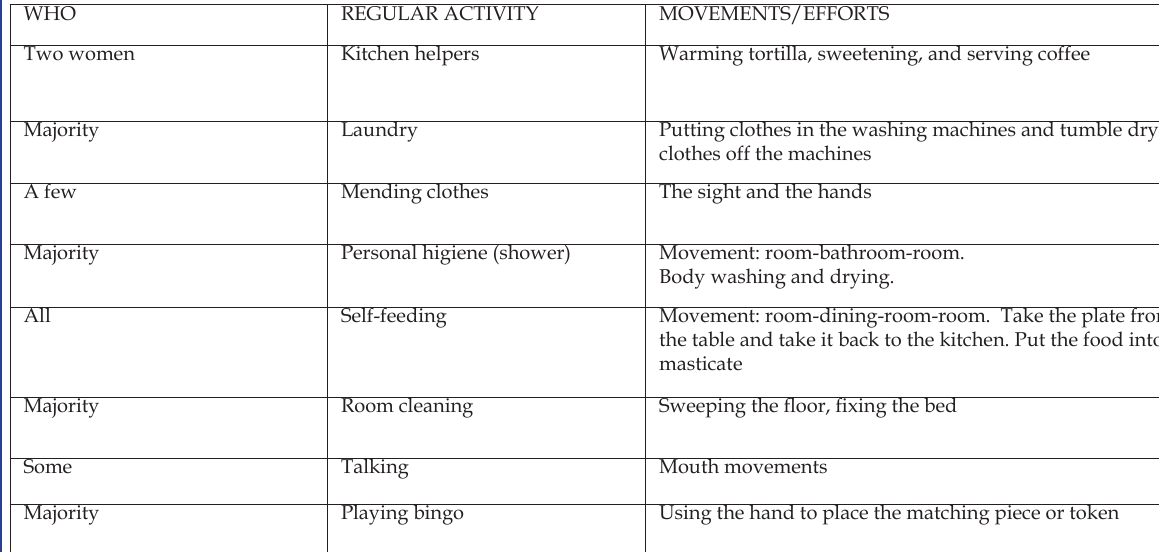
Table 2: Coresidents’ Routines